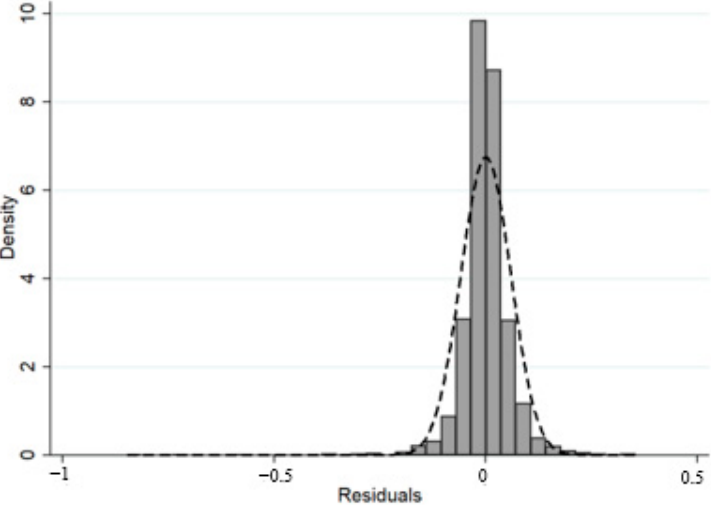
Figure 2. Residual distribution diagram.